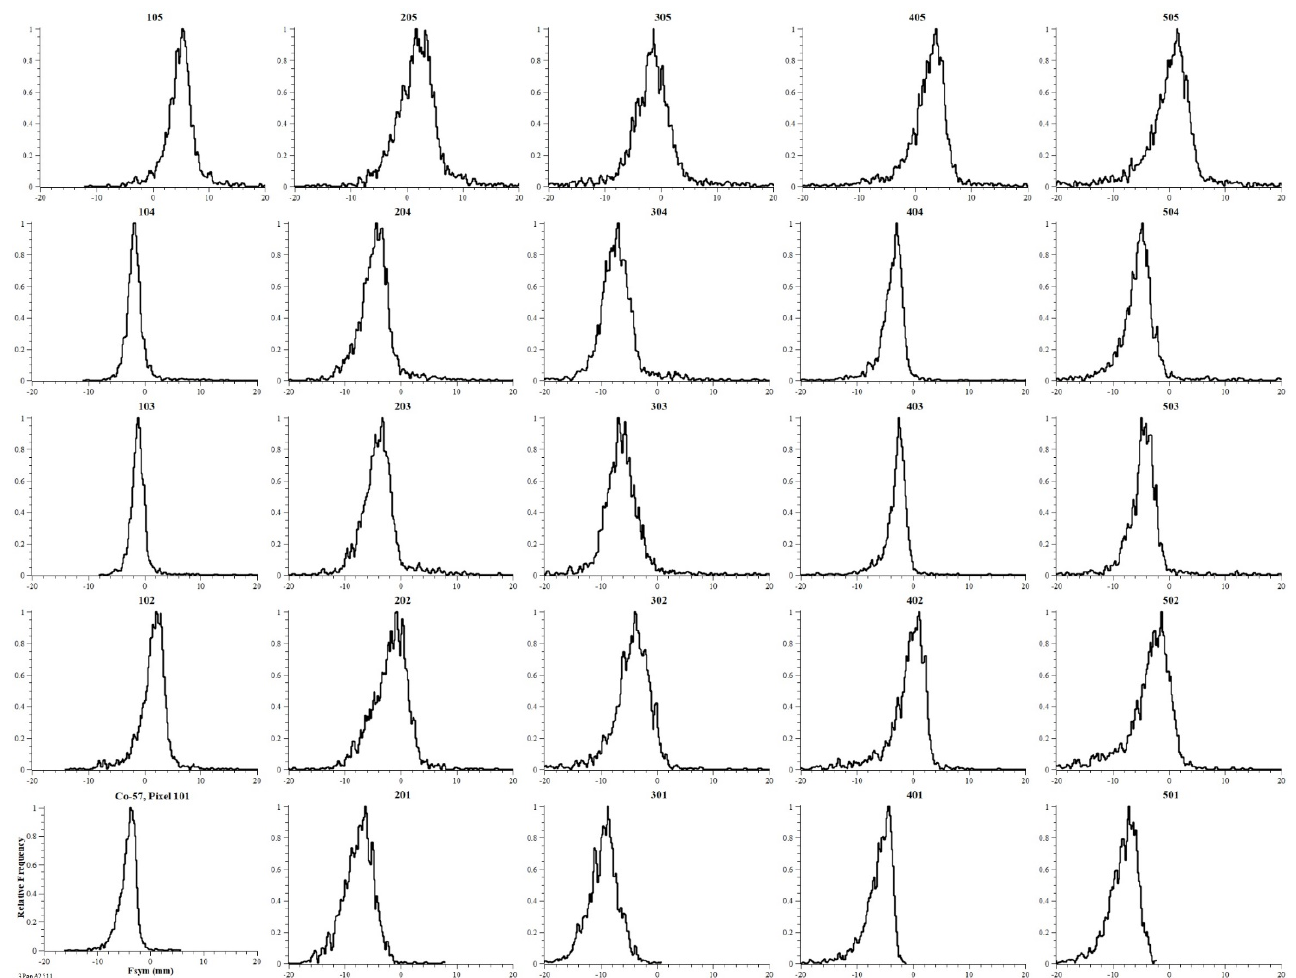
Figure A8. Fsym spectra per pixel for the first quarter of crystal-array under Co-57 point-source irradiation. The first quarter includes the pixels with RR ≤ 5 and CC ≤ 5. The common axes and the plot descriptions are reported only once in the bottom-left frame. The spectra, obtained by building histograms from single-events Fsym values with 0.2 mm binning, have undergone smoothing for denoising data. The frequency values were normalized, pixel by pixel, to the respective maximum value.